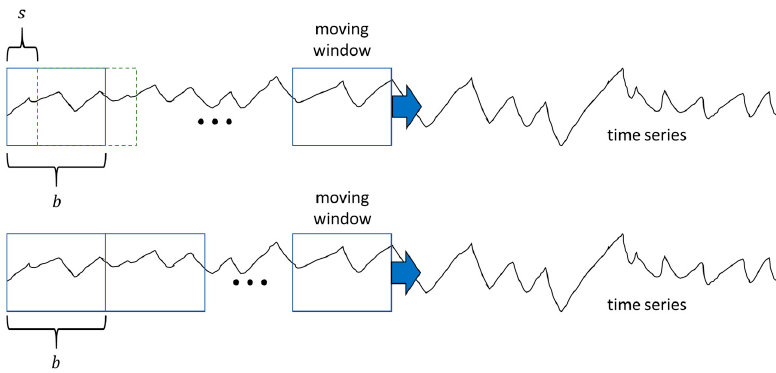
Figure 5. Online application of the model, whereby a window of length b is moved along the time series with a step size s < b (top) and s = b (bottom).